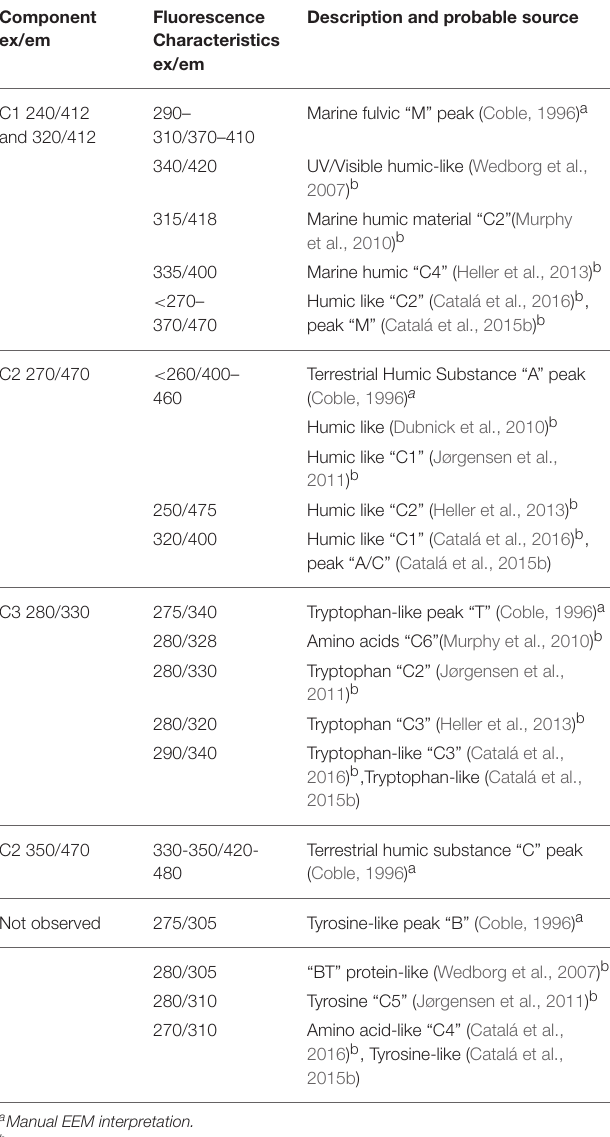
TABLE 1 | PARAFAC analysis and identification of fluorophores. Component